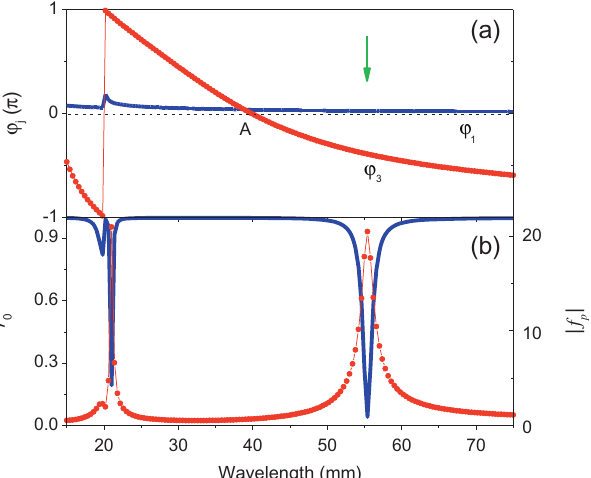
Figure 3. The SFP resonance in the microwave band for the structure with d = 20 mm, a = 0.3 mm, h = 5 mm, and t = 0.1 mm. (a) Phase shift of slit mode at the slit openings (the arrow indicates the SFP resonance); (b) Zero-order reflection (the line) and the absolute value of the FP-like resonance factor (the circles). The resonance around 20 mm is dominated by the grating surface modes.